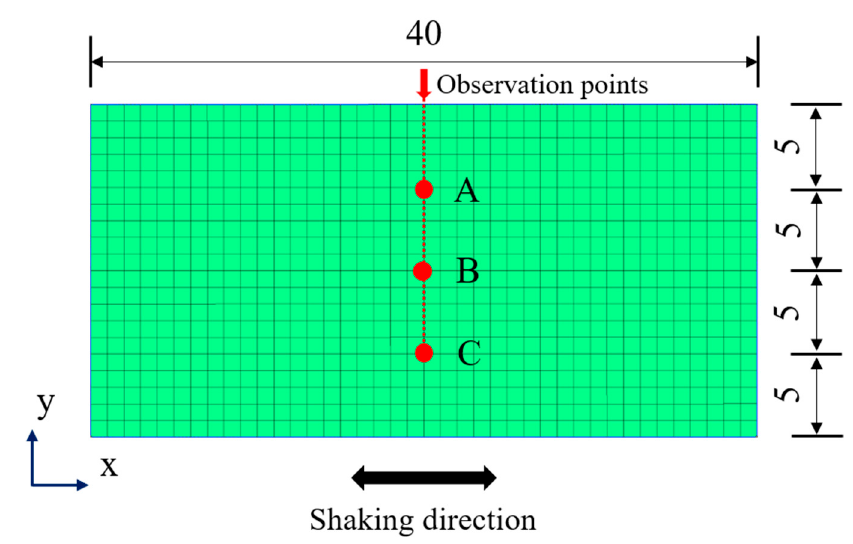
Figure 9. Diagram of FE model for level ground of saturated calcareous sand.